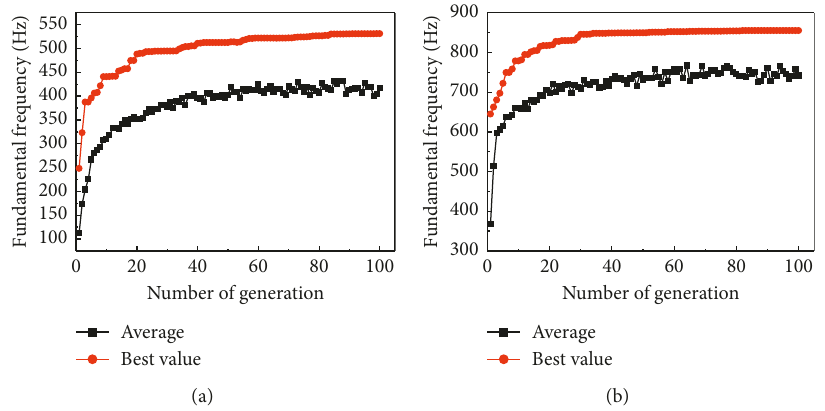
Figure 14: MIGA evolution with increased numbers of variable control points (Approach 2). (a) Shell 2. (b) Shell